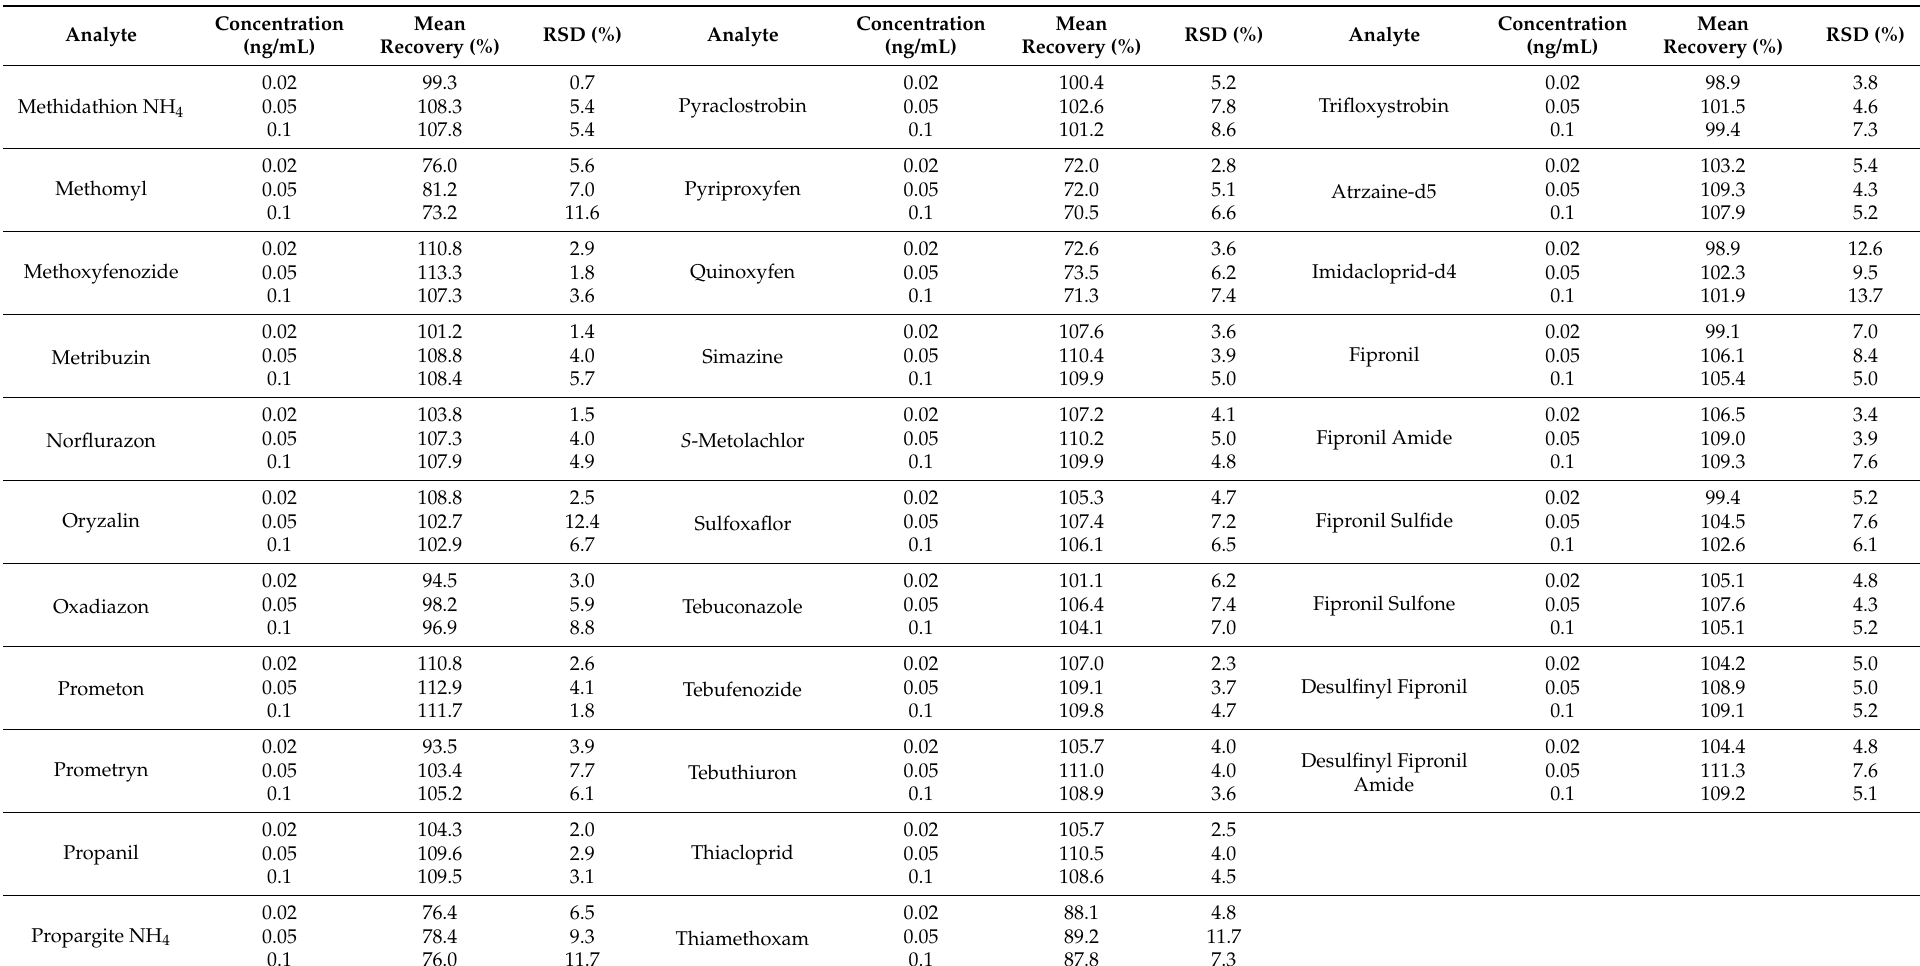
Table 5. Accuracy and precision of LC-MS/MS method for determination of 65 pesticides in surface water (n = 5).